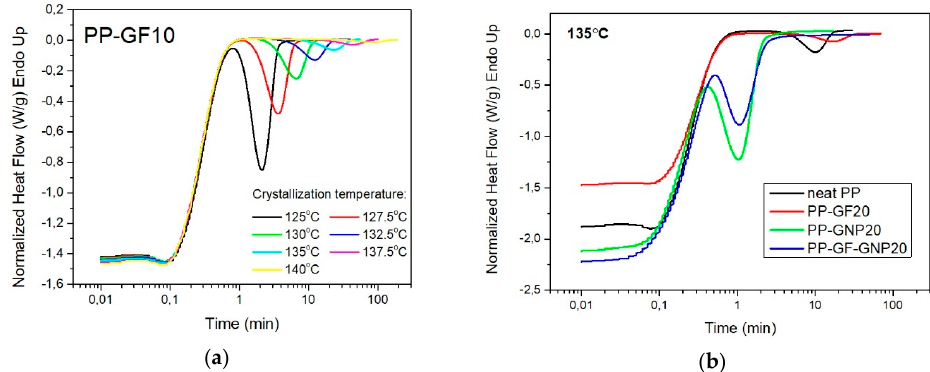
Figure 1. ( a ) Evolution of the exothermic peaks of PP–GF10 composite during the isothermal crystallization at different temperatures; ( b ) a comparative plot of neat PP, PP–GF20, PP–GNP20 and